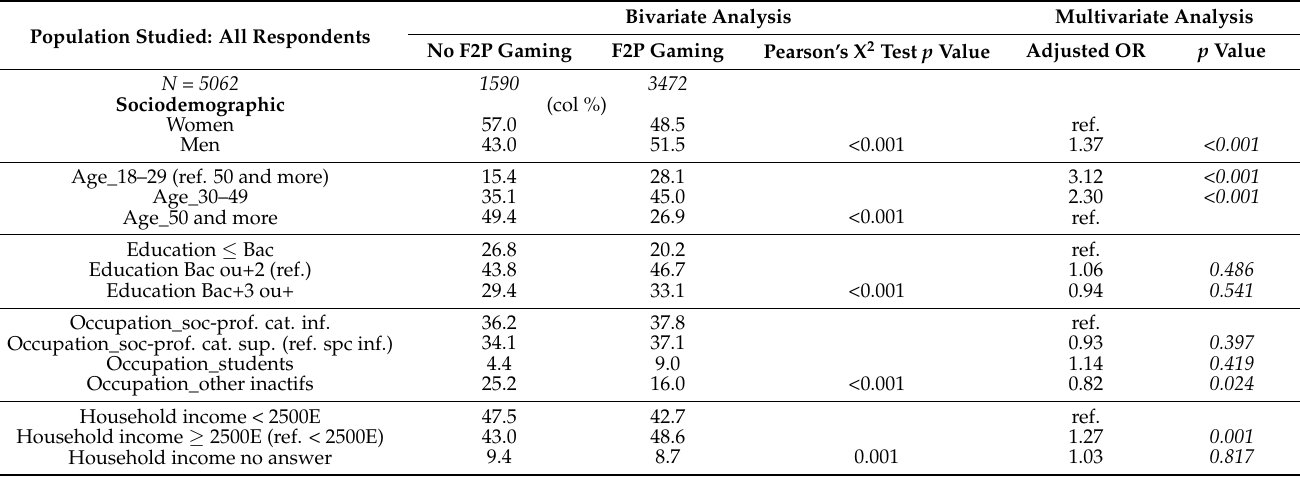
Table 1. Free-to-Play gaming—multifactorial sociodemographic predictive model.